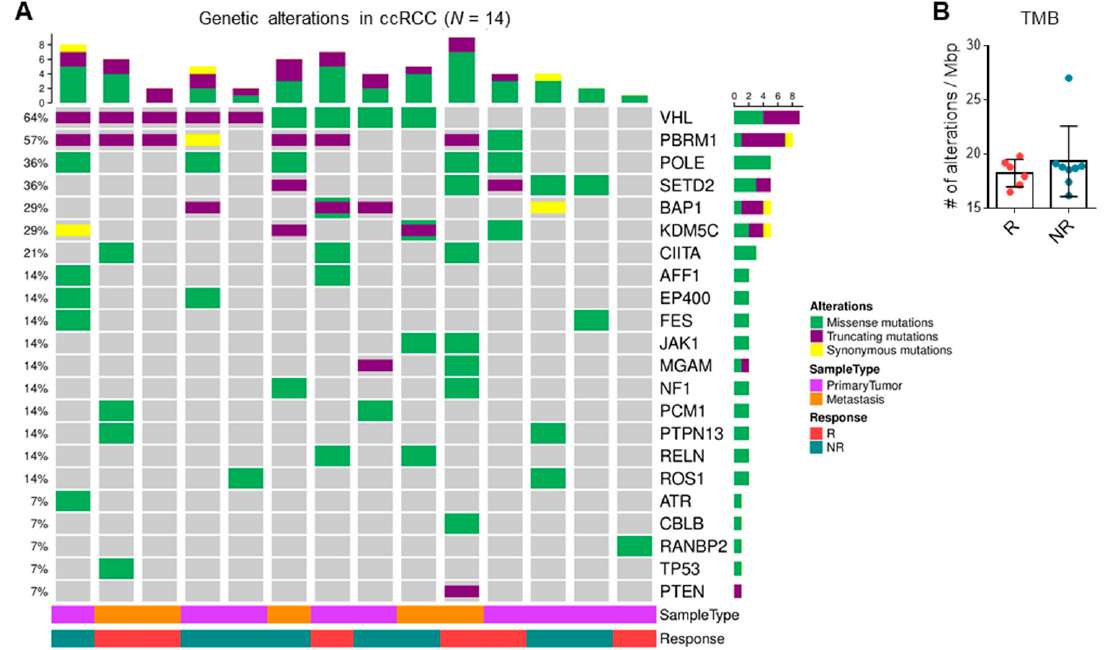
Figure 3. Tumor mutational burden (TMB) and driver mutations do not correlate with response. ( A ) Quantification of missense, truncating, and synonymous mutations in top 22 altered genes found in clear cell RCC samples. ( B ) TMB of responders ( n = 6) compared to non-responders ( n = 8) calculated based on all unfiltered variants. Data shown are averages ± SD.